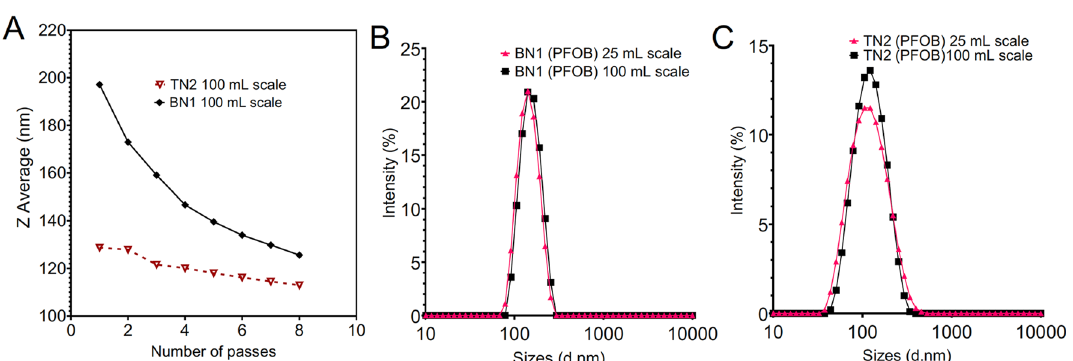
Figure 7. Characterization and scale-up of PFC nanoemulsions. ( A ) Dependence of 100 mL NE size on processing amount (n = 1 measurement/ data point). ( B ) Size distribution overlays of biphasic PFOB, BN1, at 25- and 100-mL scale. ( C ) Size distribution overlays of triphasic PFOB, TN2, at 25- and 100-mL scale. Graphs from GraphPad